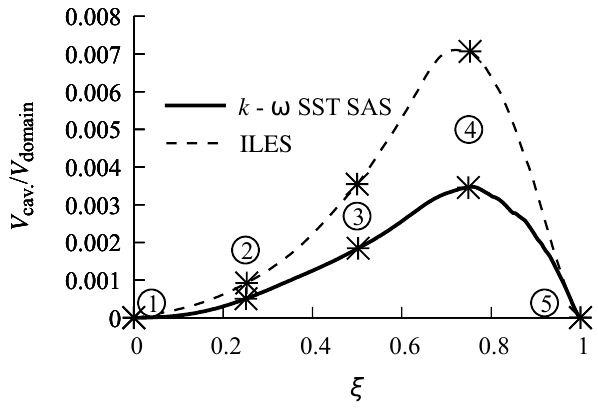
Figure 4. Selected instants at the third cycle of both cases.